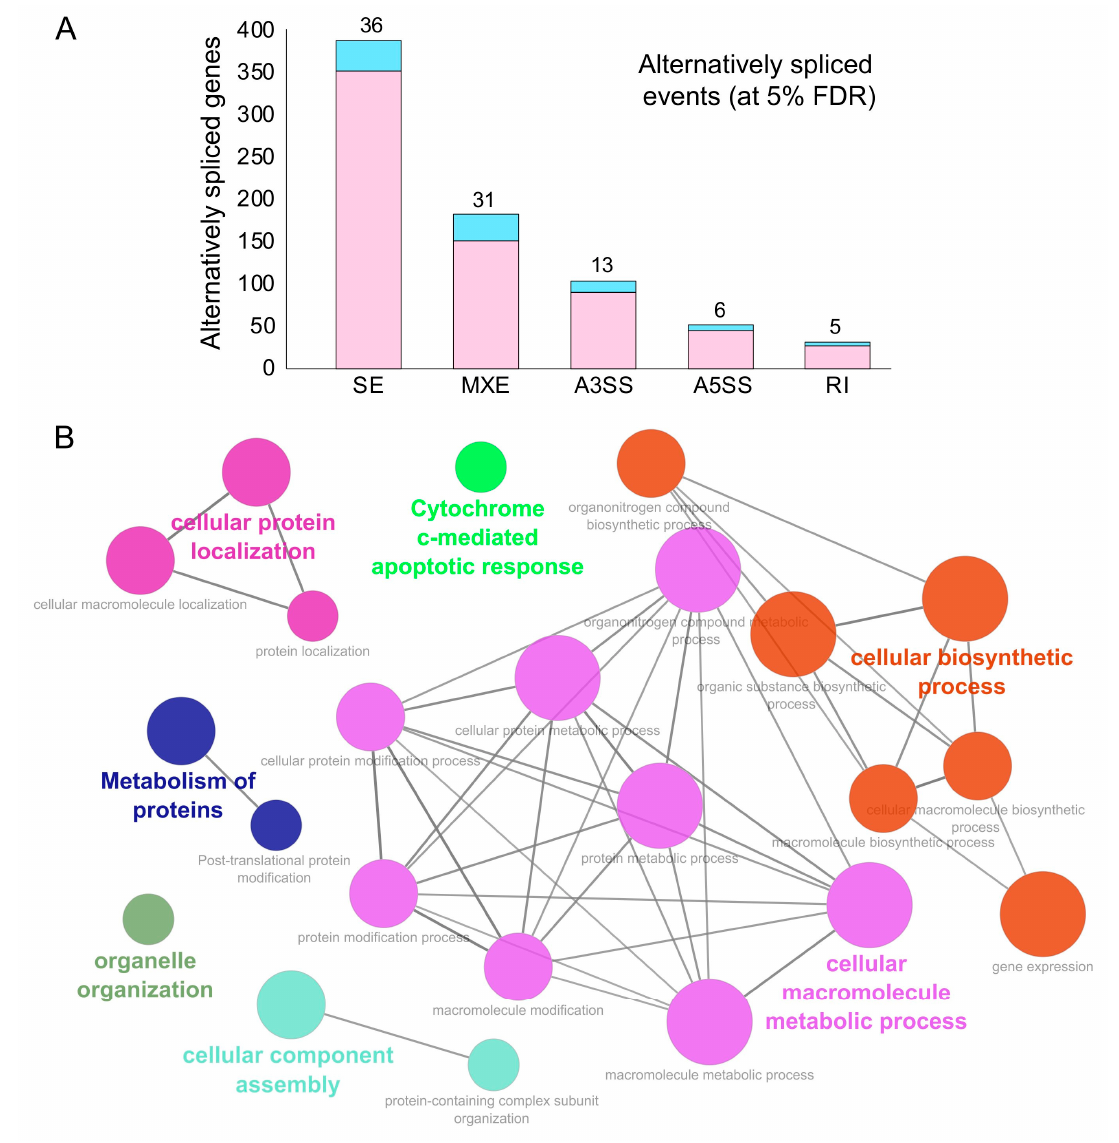
Figure 3. Alternative splicing events during SARS-CoV-2 infection. ( A ) Bar plot showing the genes (RBP-encoding genes in blue) exhibiting alternative splicing during SARS-CoV-2 infection in primary human lung epithelial cells (at 5% FDR). ( B ) Clustered GO term network obtained from the function annotation analysis and grouping of the GO term for the genes exhibiting alternative splicing using ClueGO (Cytoscape plugin). Significant clustering (adj. p < 1 × 10 − 5 ) of functional groups were color-coded by functional annotation of the enriched GO biological processes, with the size of the nodes indicating the level of significant association of genes per GO term were